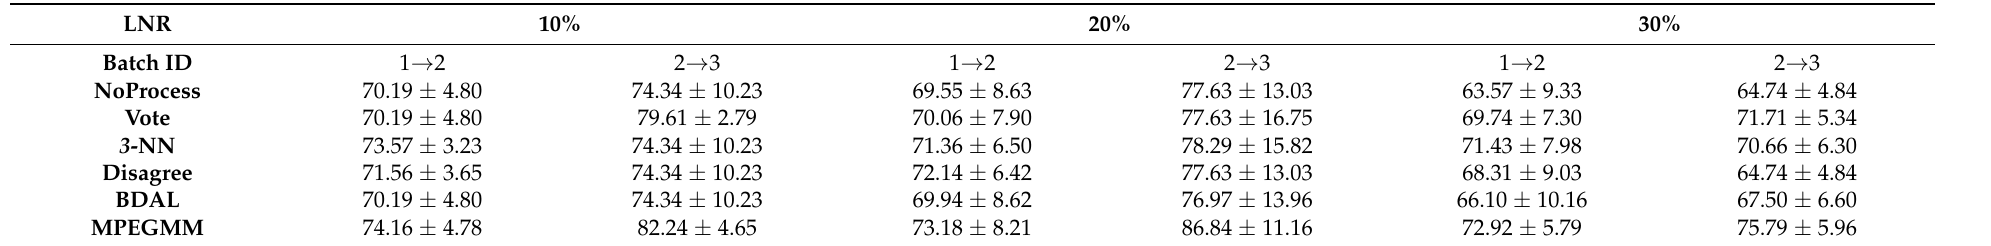
Table 5. Accuracy on dataset B under setting 2